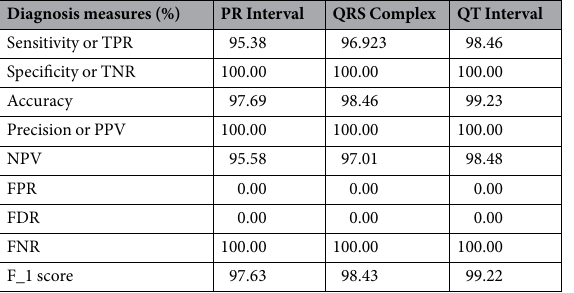
Table 2. Diagnosis measures of proposed methodology on localized